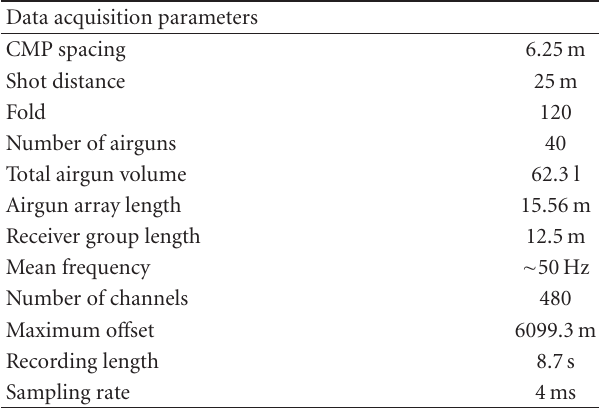
Table 1: The data acquisition parameters of reflection seismic profile BGR99-46.